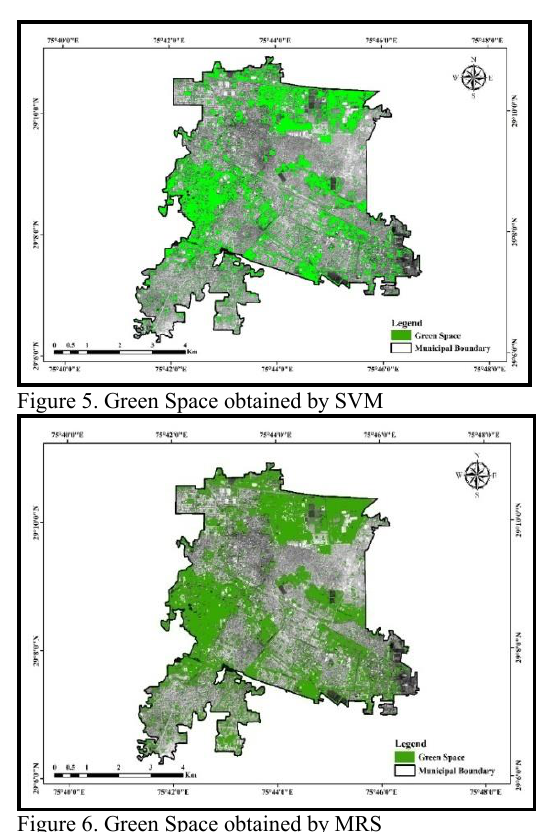
Figure 6. Green Space obtained by MRS